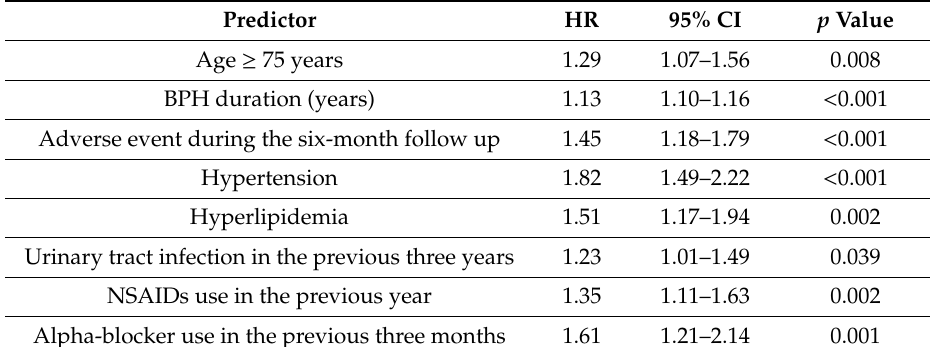
Table 5. Association between baseline characteristics and long-term use of medications for treating BPH among patients with BPH who received TURP ( n =